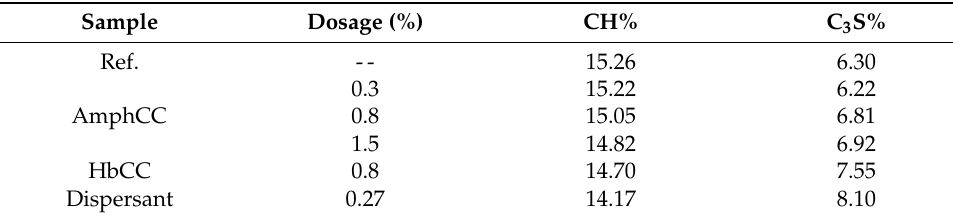
Figure 8. XRD spectra ( a ) and SEM images ( b ) of the hardened paste samples, the scale bar in subfigure b applies to all the sub-images. Table 5. Phase content of the paste samples from XRD